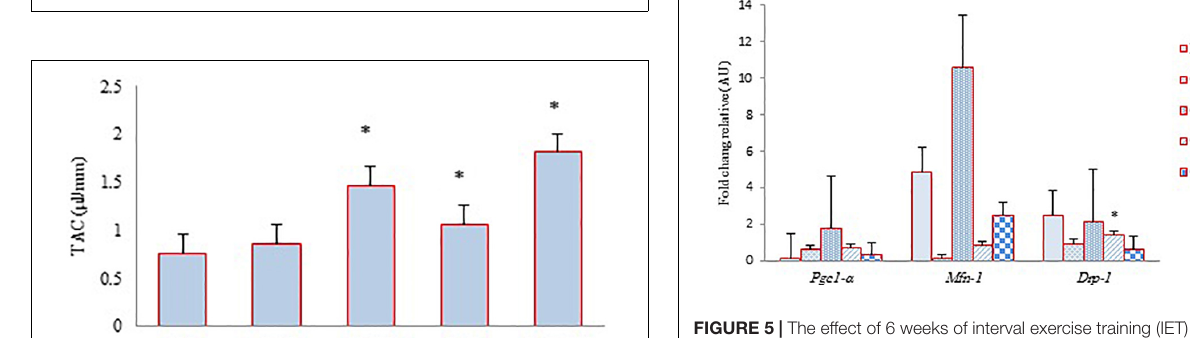
FIGURE 5 | The effect of 6 weeks of interval exercise training (IET) and vitamin D supplementation on Pgc-1 α , Mfn-1 , and Drp-1 genes expression in five control and experimental groups. H.C, untrained healthy control group; Ca.C, cancer control group; Ca.VD, cancer with injection of vitamin D group; Ca.Ex, cancer exercise training group; Ca.Ex.VD, cancer exercise training with injection of vitamin D group. Data are presented as mean ± SD. ∗ Significant level ( P ≤